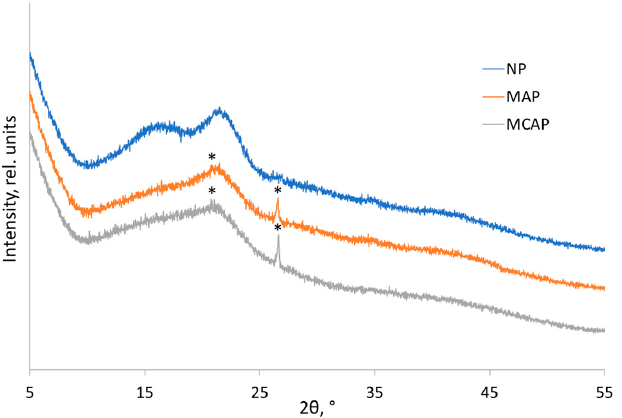
Figure 2. XRD patterns of NP, MAP, and MCAP. * shows the reflections of quartz SiO 2 (PDF-2 no. 01-070-3755). Table 3. Surface properties of natural peat (NP), mechanically activated peat (MAP), mechanochemi- cally activated peat (MCAP).